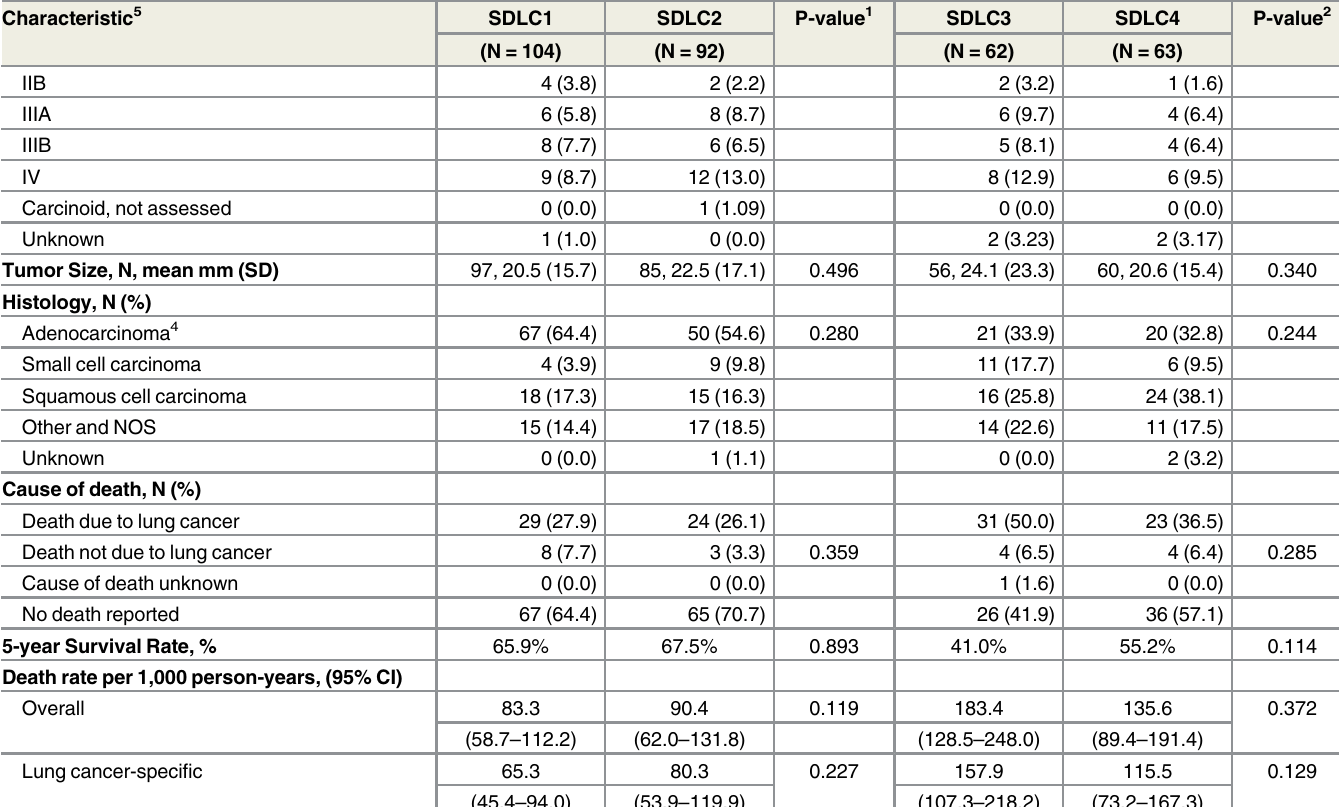
(P < 0.001) higher percentage of adenocarcinomas (54.1%) compared to the SDLC1/2 cases (33.8%). Interval lung cancers had the highest percentage of small cell carcinomas (31.8%) compared to SDLC1/2 (6.5%), SDLC3/4 (13.6%) and prevalence lung cancers (5.6%). The only significant difference in stage distribution was that interval lung cancers had a sig- nificantly higher percentage of stage III (40.9%) and IV (31.8%) lung cancers (P < 0.001) com- pared to SDLC1/2 (14.3% and 10.7%), SDLC3/4 (15.2% and 11.2%) and prevalence lung cancers (15.2% and 19.3%). The mean tumor size was significantly higher for prevalence lung cancers (25.5 mm SD = 17.2) and interval lung cancers (41.1 mm SD = 21.7) compared to SDLC1/2 (21.3 mm SD = 16.3) and SDLC3/4 lung cancers (22.3 mm SD = 19.6). Patient outcomes and Kaplan-Meier survival analyses Cause of death (Table 3) was significantly different between the combined screen-detected cases (P = 0.007). The absolute number and percentage of participants in the SDLC1/2